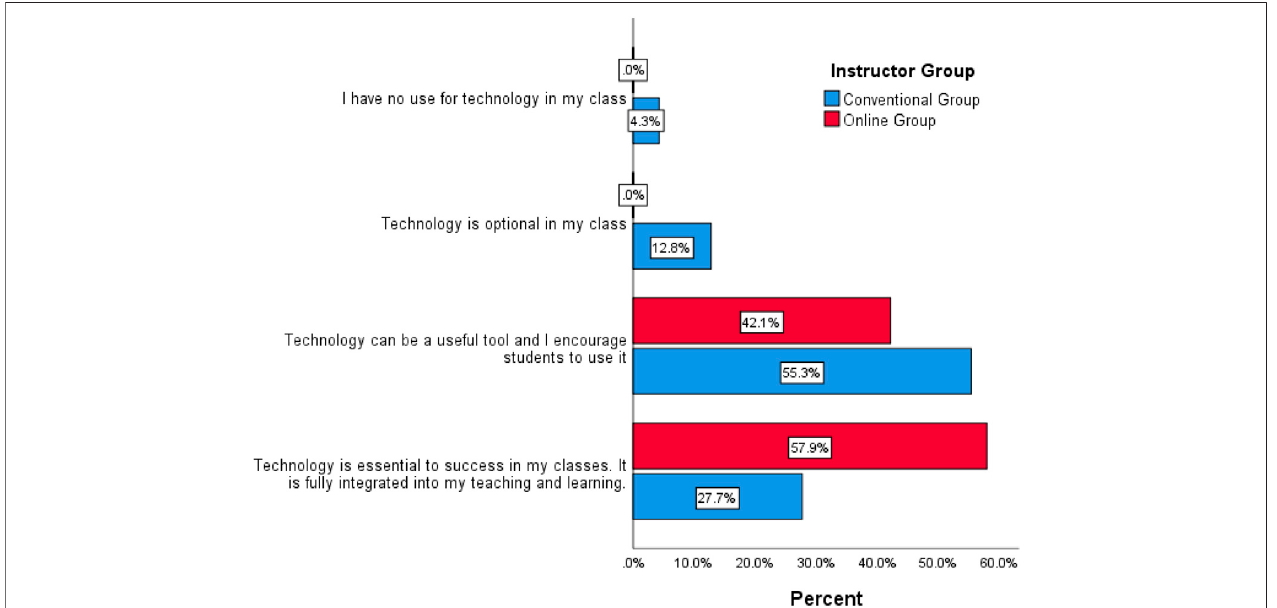
FIGURE 6 | Extent of instructional integration of technology for the Online Group and Conventional